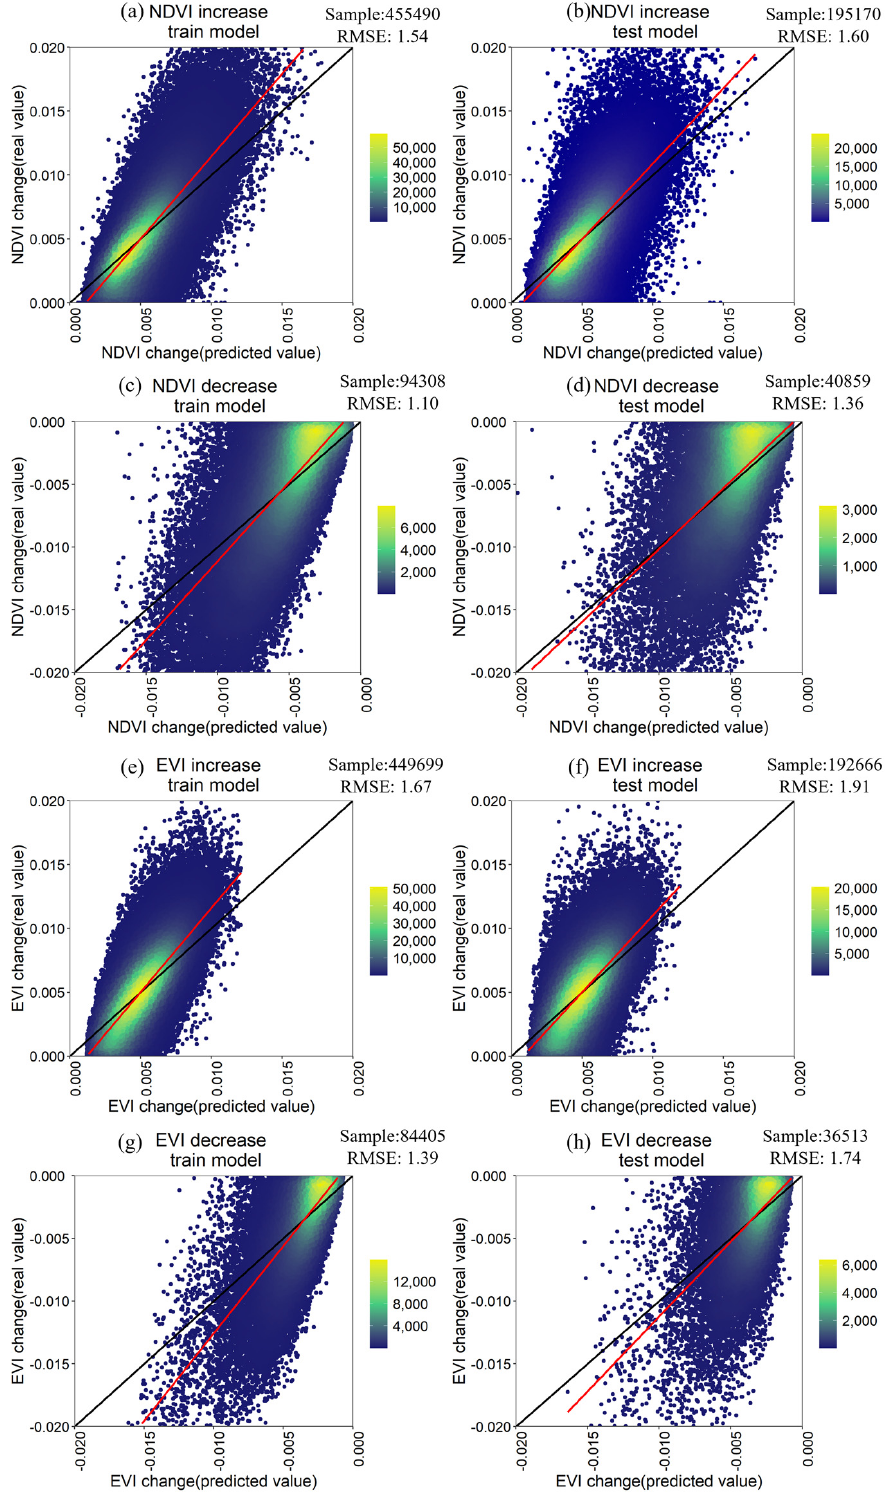
Figure 9. Accuracy assessment of Random Forest regression. ( a , b ) the accuracy of random forest in NDVI increases based on the train and test models, respectively. ( c , d ) accuracy of rando forest in NDVI decreased based on the train and test model, respectively. ( e , f ) accuracy of rando forest in EVI increase based on the train and test model, respectively. ( g , h ) accuracy of rando forest in EVI decreased based on the train and test models, respectively.